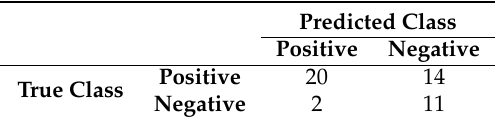
Table 7. Percentage of hits and misses in the forecasts (yellow alert).